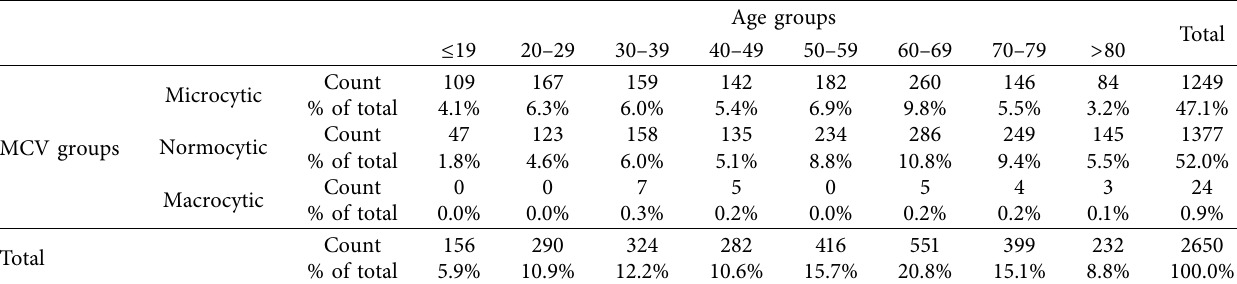
Figure 3: Anemia groups stratified based on hemoglobin concentration for female gender and age. Table 5: Prevalence of morphological types of anemias across age groups in